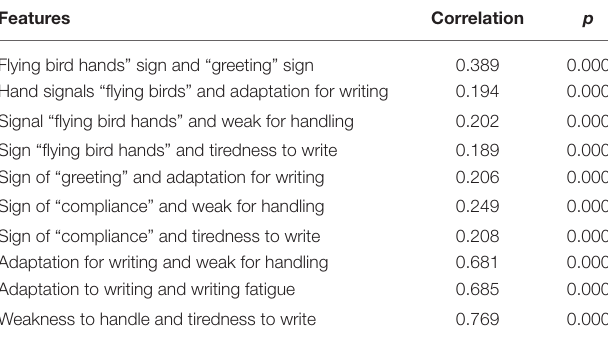
TABLE 4 | Analysis of the correlation between physical signs of JH in the